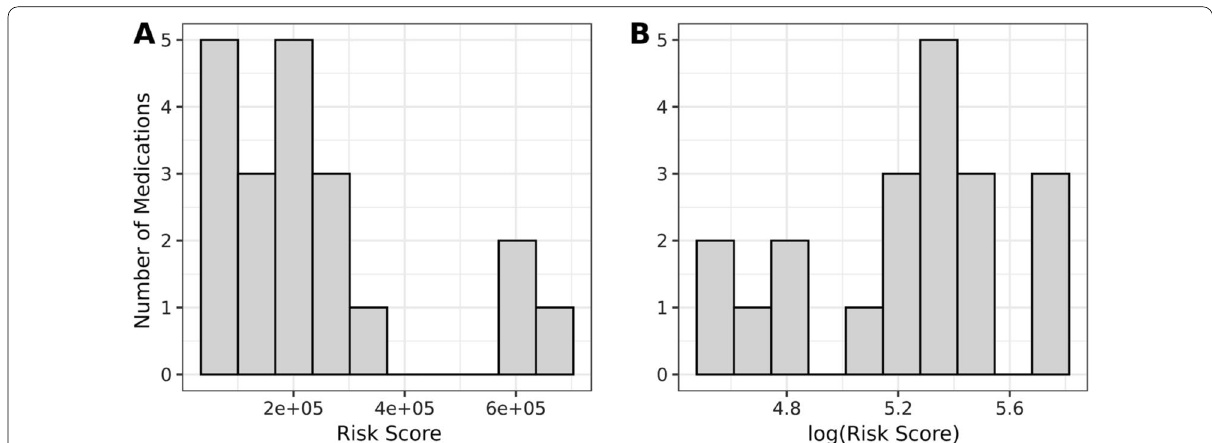
Fig. 1 Risk score distribution for PA medication list as average scores (left) and log scores (right). The raw scores are highly right skewed (skewness 1.28), whereas the log scores are normally distributed (D’Agostino-Pearson P =